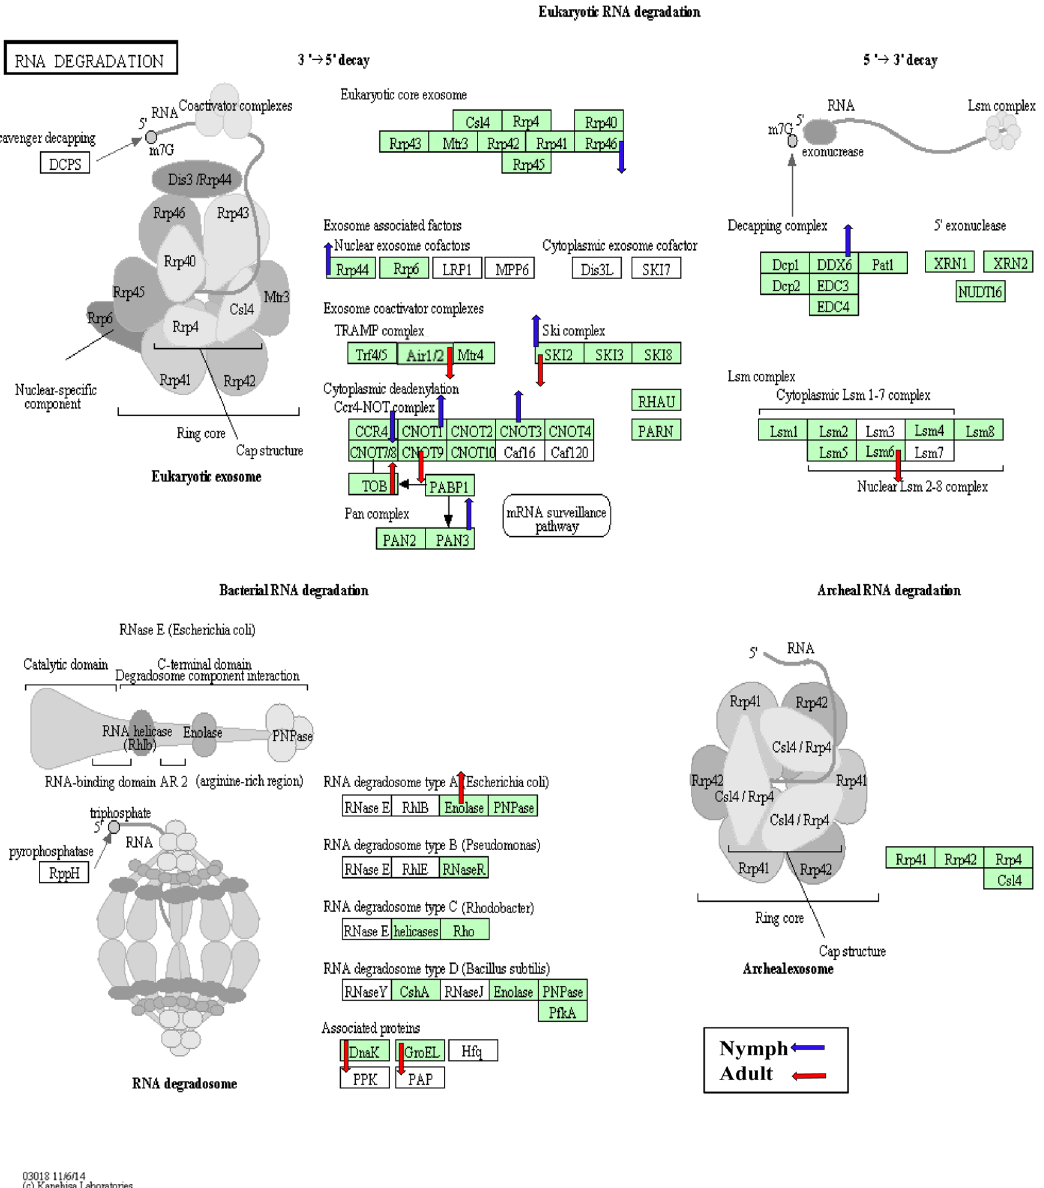
Fig 7. The RNA degradation KEGG pathway diagram showing the contigs that were differentially expressed ( p < 0.05) in nymphs (blue arrows) and adults (red arrows) in response to CLas infection. Of the assigned contigs (shaded in green), 17 were differentially expressed either in the nymphs or